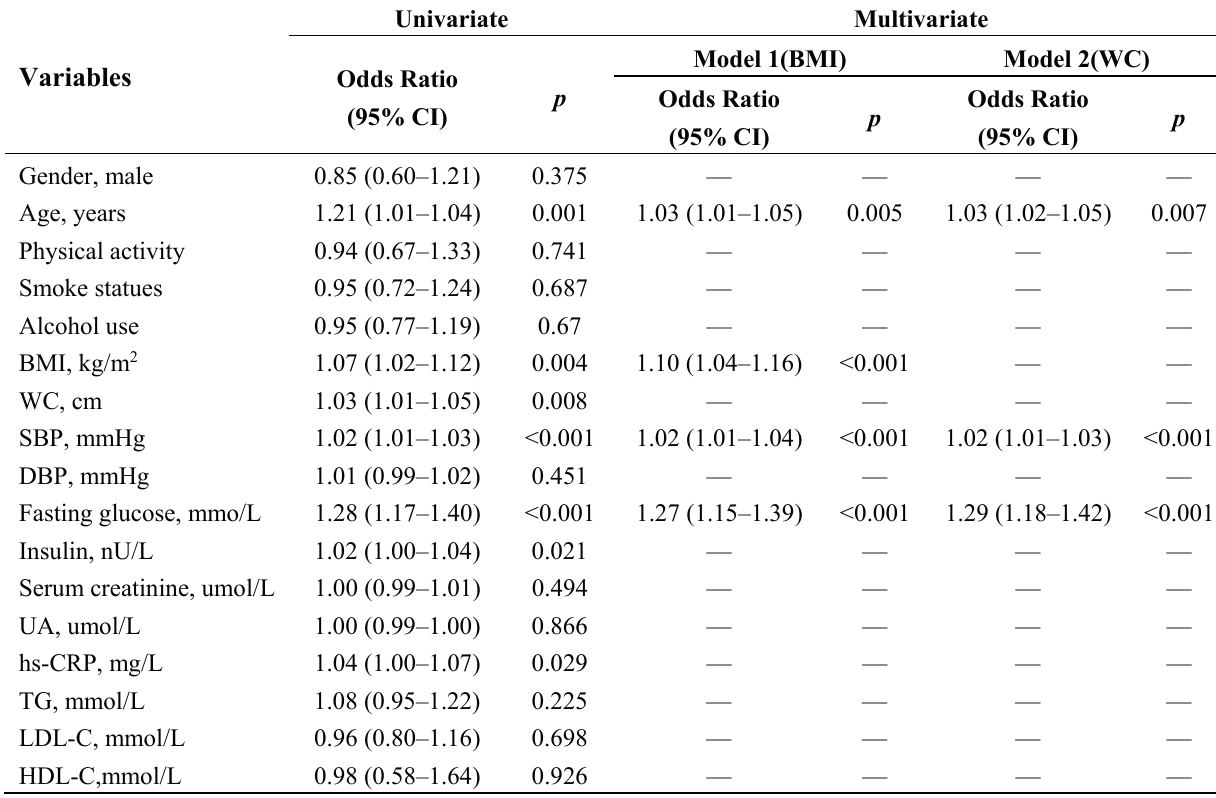
Independent variables in the multivariate model were chosen using a backward stepwise regression analysis where all variables listed in the univariate analysis. BMI and WC were selected into model 1 and model 2 separately. Serum insulin was excluded from the multivariate model due to possible multicollinearity. The goodness-of-fit of the logistic regression models was assessed by the Hosmer and Lemeshow test, and the p value was 0.525, and 0.277 for model 1 and model 2, respectively. Abbreviations: ACR, albumin to creatinine ratio; BMI, body mass index; WC, waist circumference; SBP, systolic blood pressure; DBP, diastolic blood pressure; eGFR, estimated glomerular filtration rate; UA, uric acid ; hs-CRP, high sensitivity C-reactive